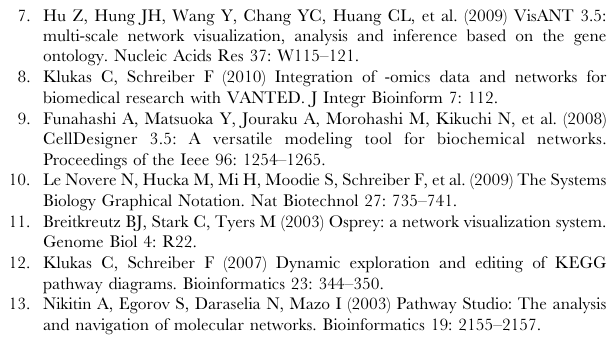
Table S1 Comparison of major functionalities between BiNA, Cytoscape, VANTED, and CellDesigner. The table shows a comparison of major functionalities between BiNA, Cytoscape, VANTED, and CellDesigner. Since all tools are extendable by plug-ins, we compare the distributed versions and mark features fulfilled by an additional plugin with an asterisk. Major differences of the tools can be found in the data access methods, where the functionality of BiNA is heavily affected by the presence of the BN ++ data warehouse, which provides access to a large number of integrated databases. Another essential difference is BiNA’s network visualization model, which is based on hierarchical graphs and focuses comprehensive, dynamic, and interactive visualizations for metabolic, regulatory, and signaling networks of high quality. Although, CellDesigner has also a hierarchical visualization model supporting hierarchical group- ings, it is more focused on metabolic network simulation and lacks explicit functionality for regulatory and signaling network